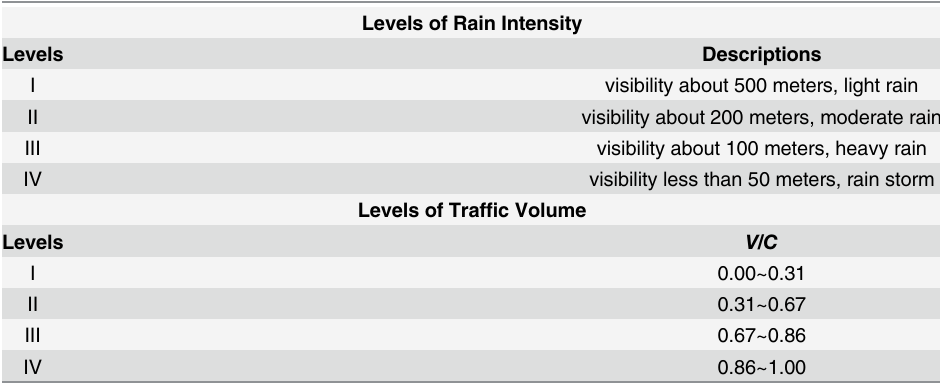
Table 1. Category descriptions of rain intensity and traffic